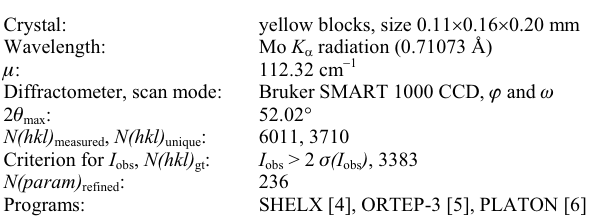
Table 1. Data collection and handling.